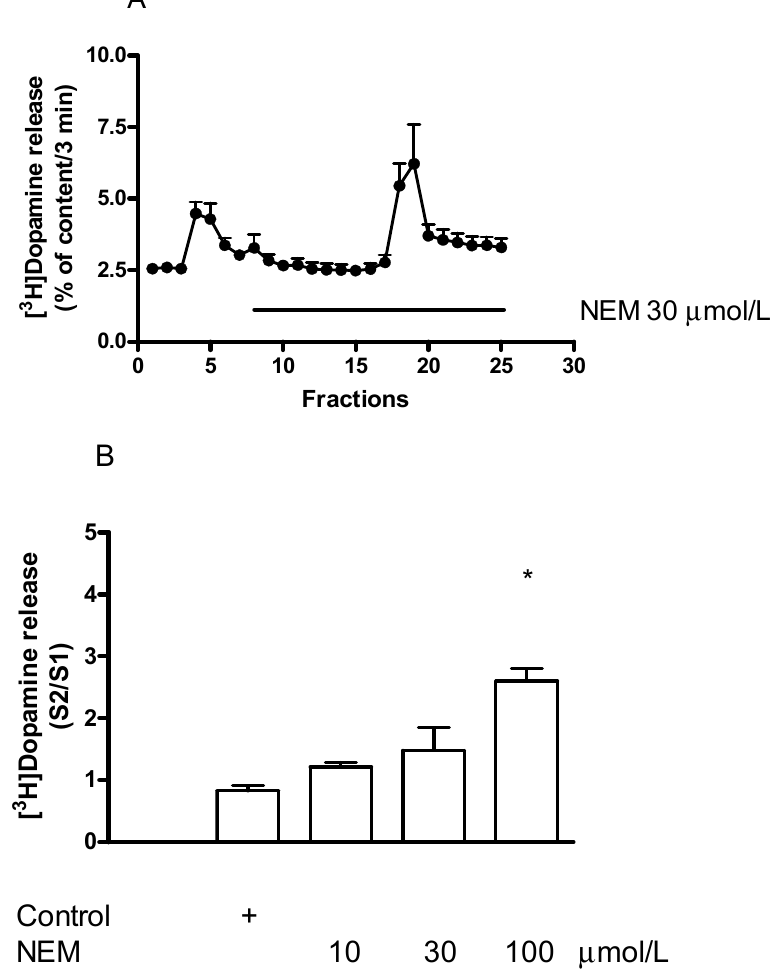
Figure 18. Effect of N-ethylmaleimide (NEM) on [ 3 H]dopamine release from rat striatum. For the experimental procedure, see Figure 2A. ( A ) Filled circles indicate [ 3 H]dopamine release in the presence and absence of NEM. NEM was added to striatal slices from fraction 8 in a concentration of 30 µ mol/L and maintained through the experiment. Resting release expressed by the B2/B1 ratio was 0.93 ± 0.06 in control, and it was 1.07 ± 0.07 in the presence of NEM, not differing significantly. The electrical stimulation-induced release expressed by the S2/S1 ratio was 0.88 ± 0.06 in the control and 1.63 ± 0.23 in the presence of 30 µ mol/L NEM, p = 0.009. Student t -statistics for two-means, mean ± S.E.M., n = 7-7. ( B ) NEM increased electrical stimulation-induced [ 3 H]dopamine release in rat striatum. NEM was added to striatal slices from fraction 8 in a concentration range varied from 10 to 100 µ mol/L and maintained through the experiment. One-way ANOVA followed by the Dunnett’s test, F(3,11) = 13.32, p = 0.006, * p < 0.05, mean ± S.E.M., n = 3-4.